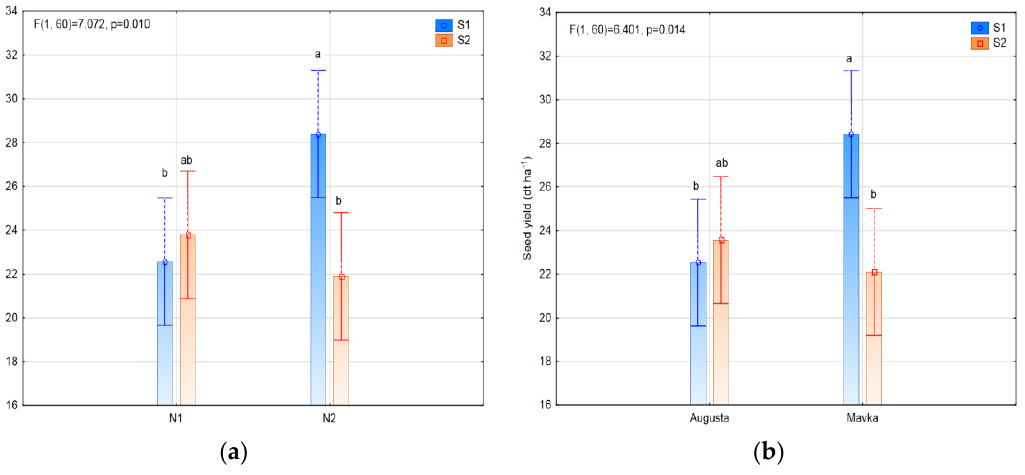
Figure 4. Significant interactions between sowing date and fertilizer ( a ) and sowing date and cultivar ( b ) on soybean yield. The standard error (SD) of each mean is presented as an error bar. The occurrence of the same letter pointer at averages (at least one) means that there is no statistically significant difference between them.